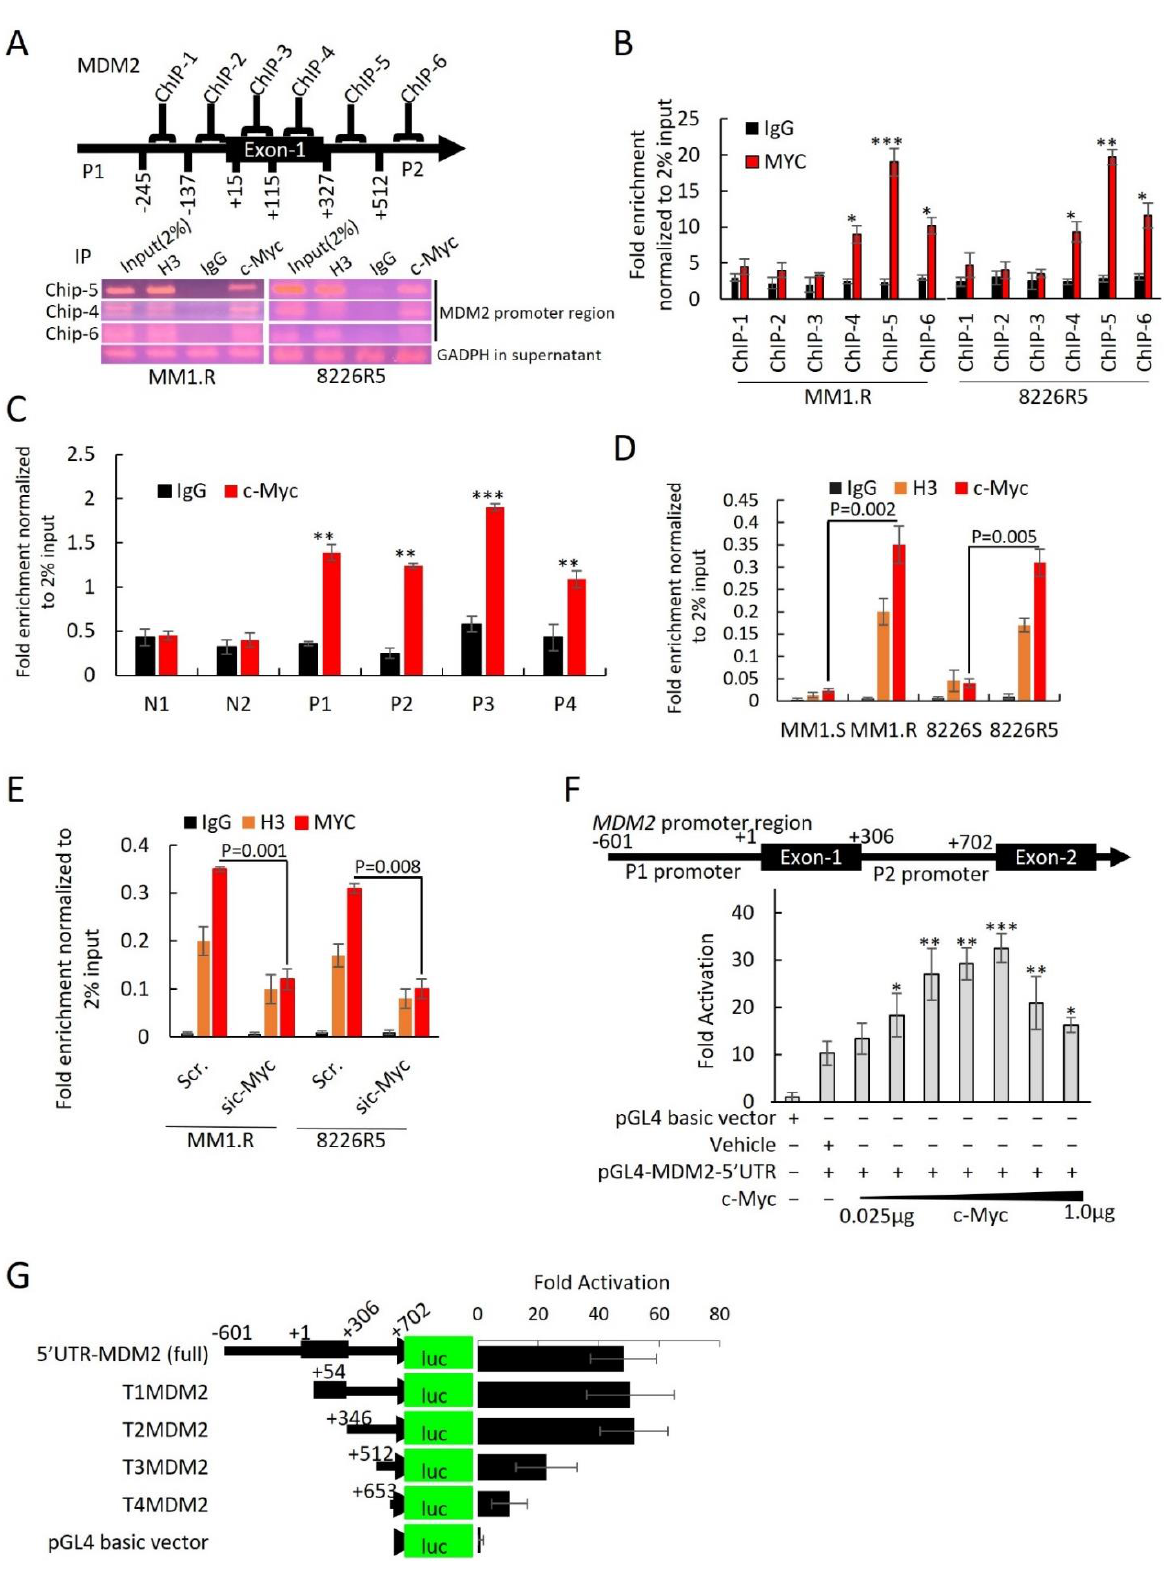
Figure 6. MDM2 is a direct transcriptional target of c-Myc. ( A ) Schematic diagram of the ChIP primers position on MDM2 promoter. Agarose gel image illustrating the ChIP-5, ChIP-4, and ChIP-6P regions of the promoter for 8226R5 and MM1.R cell lines that binds c-Myc after immunoprecipitation with specific anti–c-Myc Ab, negative control IgG, and positive control H3. Input represents 2% of total cross-linked, reversed chromatin before immunoprecipitation. GAPDH in the supernatant was used as loading control. ( B ) ChIP by c-Myc or IgG antibodies. The ChIP-qPCR was performed